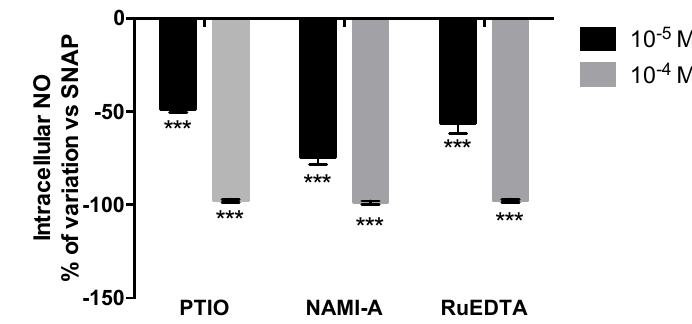
Figure 8. Concentration-dependent effects of the contemporary treatment with NAMI-A, Ru-EDTA, and PTIO on SNAP induced NO production/release by EA.hy926 cells. EA.hy926 cells were treated with 3 × 10 − 4 M SNAP ± 10 − 5 and 10 − 4 M concentration of compounds for 2 h. Then, NO was measured in the extracellular medium by Griess test ( A ) or at intracellular level by the fluorescent dye DAF-2 DA; ( B ) Data are expressed as per cent of variation vs. SNAP treated cells and are the mean ± S.E.M. of five samples per group. ANOVA and Tukey–Kramer: *** p < 0.001 vs. Control. The treatment with NAMI-A, RuEDTA, and KP1339, as well as with the positive control PTIO, for 2 h before the cell exposure to the NO donor SNAP, maintained their ability to reduce the NO levels inside the cells (Figure 9B). The effect was similar for the three ruthenium compounds, although quantitatively attenuated, in comparison to that observed with the contemporary treatment (approximately − 25% vs. − 90%; compare Figures 9B and 7B). As expected, the pre-treatment with the ruthenium compounds, as well with PTIO, was completely ineffective to modulate the NO levels in the extra-cellular medium (Figure 9A).